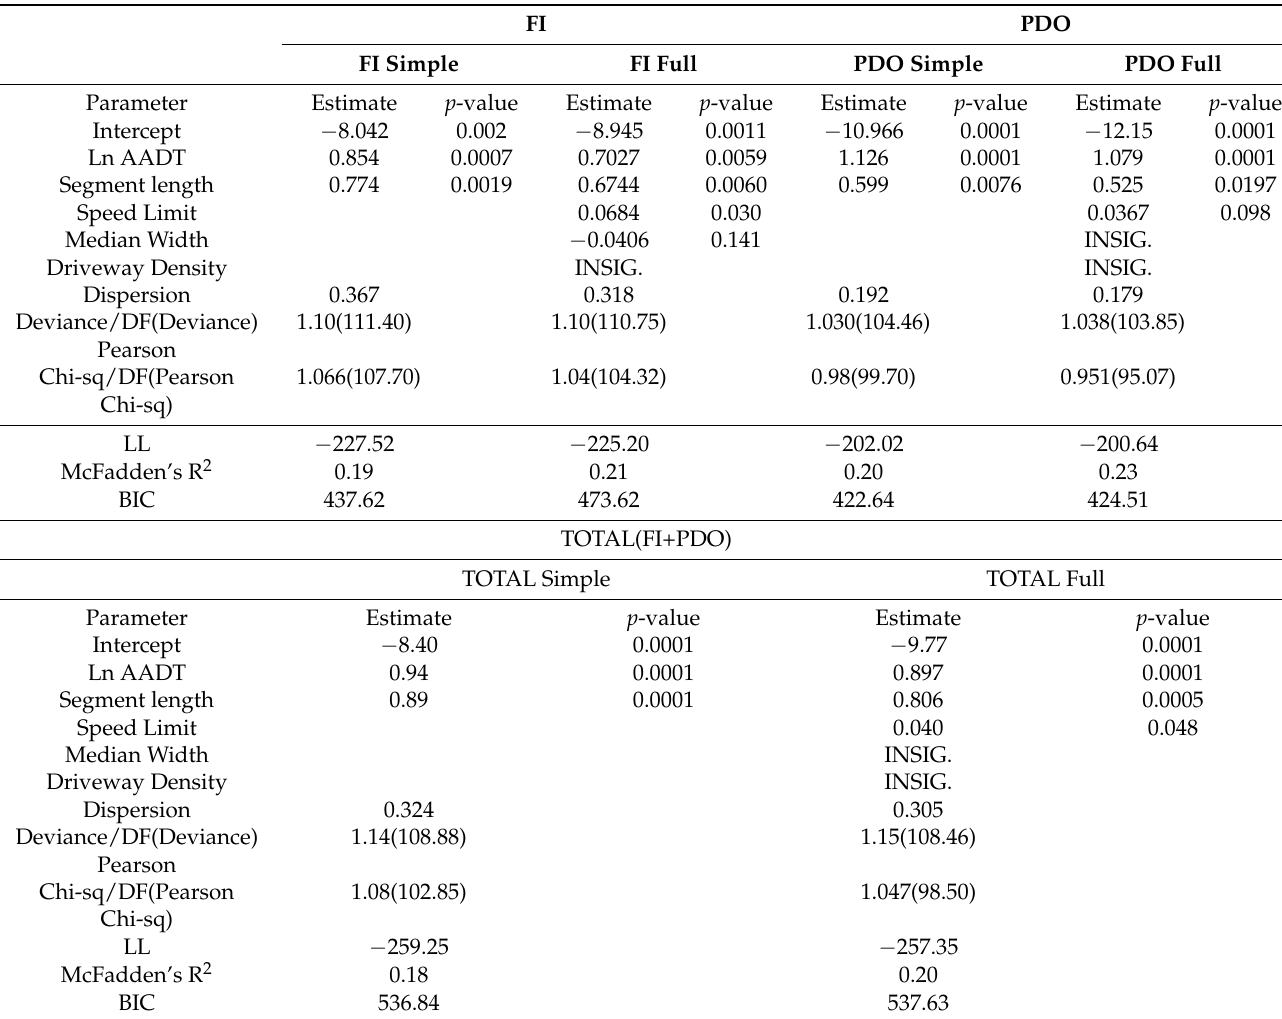
Table 3. Crash Severity